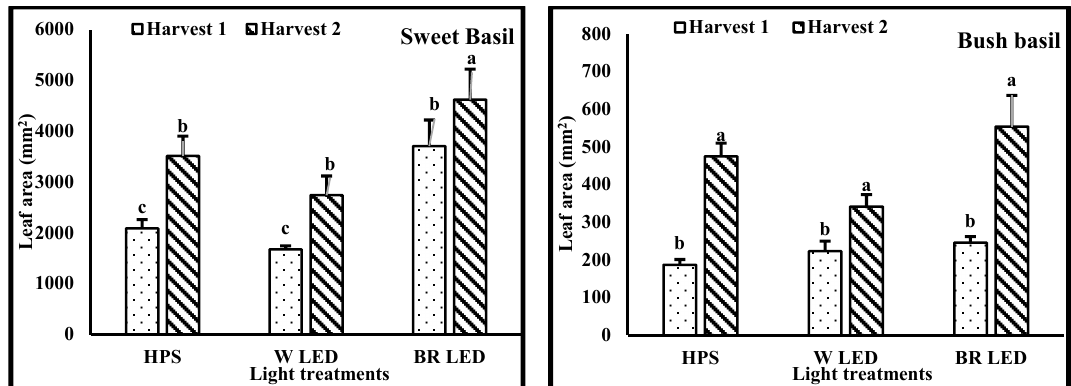
Figure 6. The effect of light treatments and harvest stage on the leaf area LA in sweet basil (LSD = 663.1 for the light treatments, LSD = 541.4 for the harvest stage) and bush basil (LSD = 68.4 for the light treatments, LSD = 55.9 for the harvest stage and LSD = 96.8 for the interaction between light treatments and harvest stage). Different letters denote significant differences between treatments ( p < 0.001).